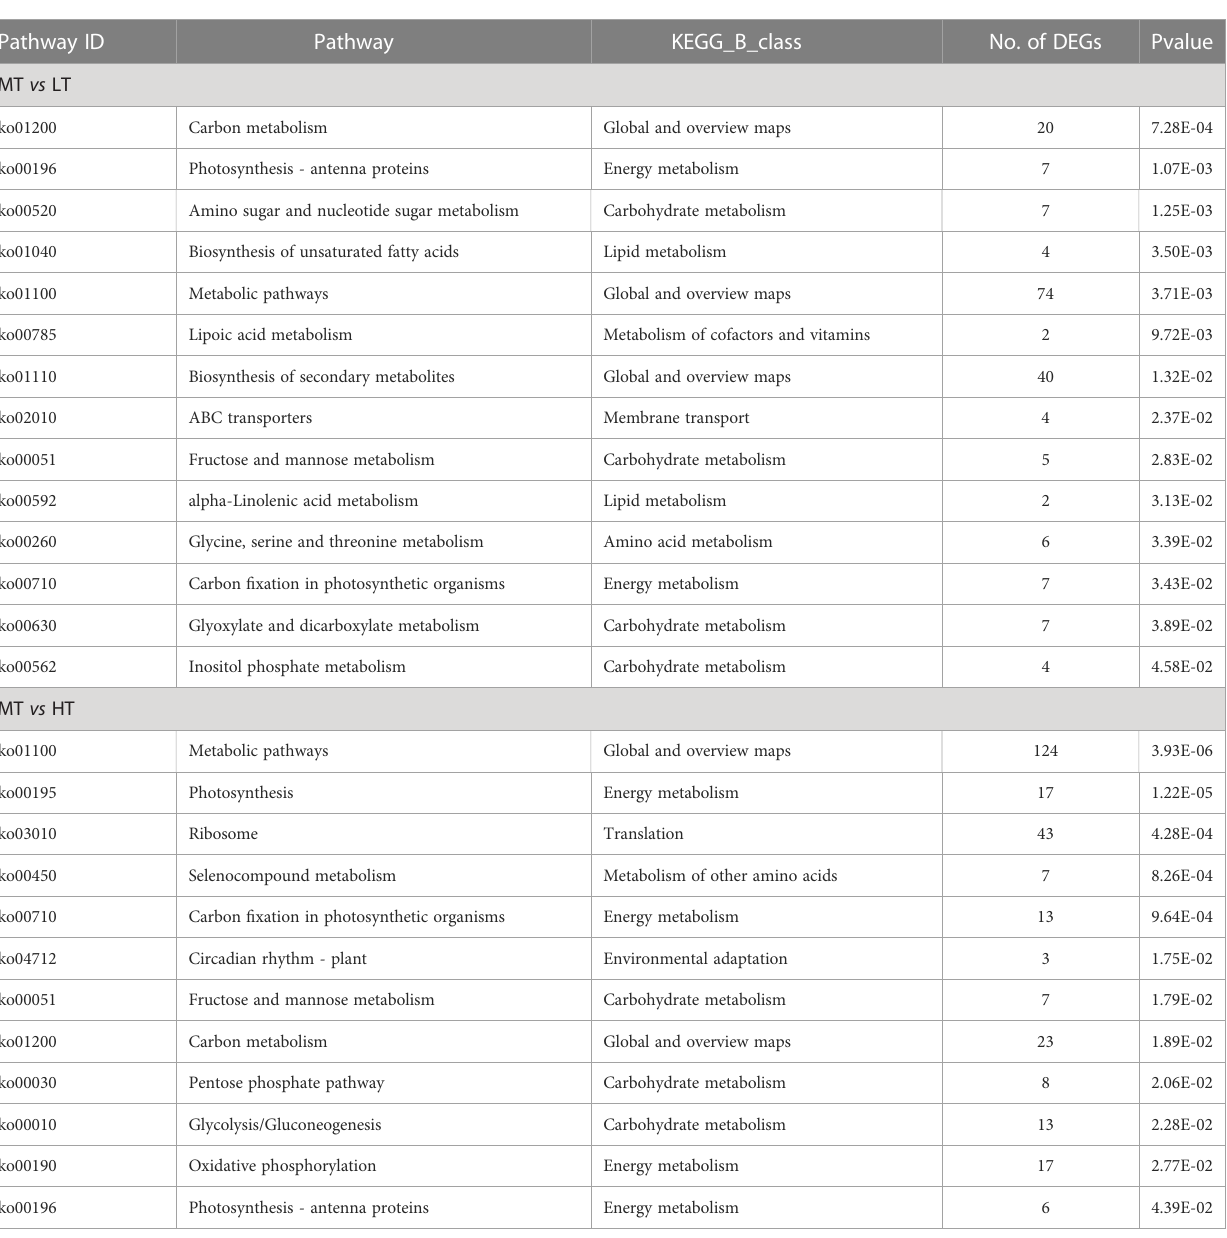
TABLE 1 Signi fi cantly enriched KEGG pathways in MT vs HT and MT vs LT. Pathway